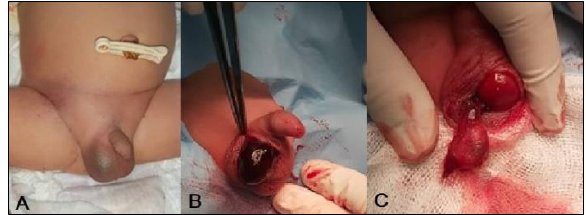
Figure 6: A) Showing inguinoscrotal swelling and ecchymosis. B) Operative picture showing hematocele and hematoma. C) After hematoma evacuation